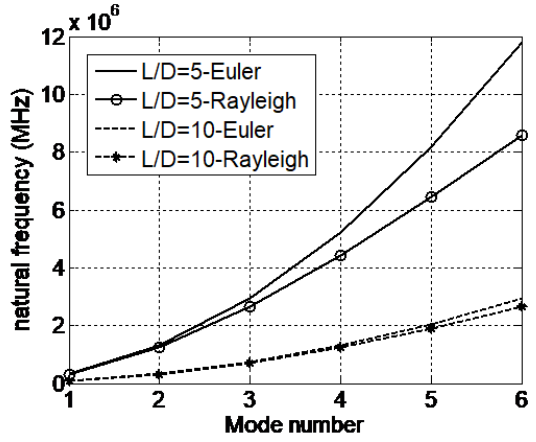
Figure 4: Effects of mode number and thickness-to-diameter ratio on the classical natural frequencies of carbon nanotube